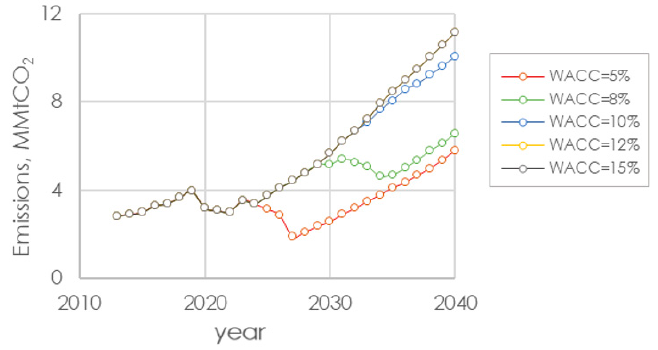
Figure 8. Power system emissions for all WACC scenarios.